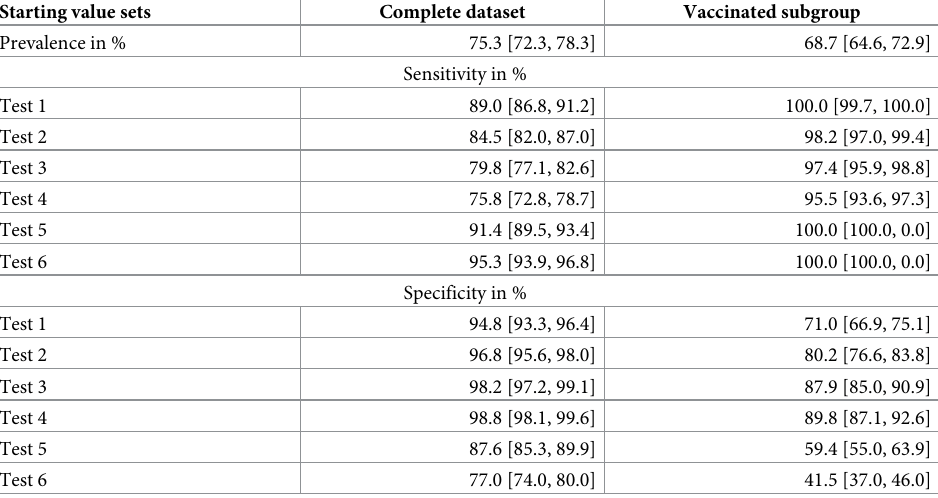
Table 3. Resulting values for the prevalence and the test accuracies for starting value set RI (test accuracies esti- mated by researchers with assumption of independent tests) for the complete sample and the vaccinated subgroup with confidence limits reported in brackets (rounded to one